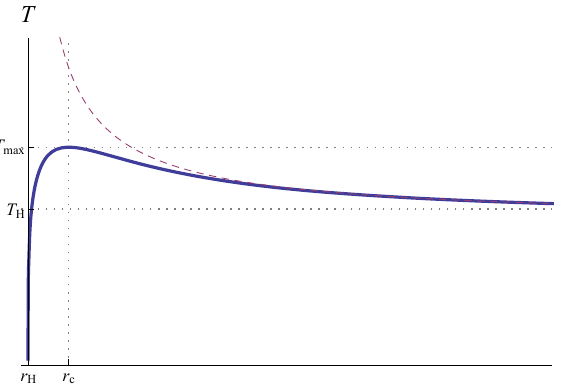
Fig. 1 The dashed curve shows the behavior of the usual Tolman temperature of being divergent on the horizon. The solid curve is the effective Tolman temperature, which is finite everywhere. In particu- lar, it vanishes at the horizon and has a maximum T max ∼ 1 . 51 T H at r c ∼ 1 . 31 r H . All the curves approach the Hawking temperature at infinity,whereastheyareverydifferentfromeachothernearthehorizon where quantum effects are significant